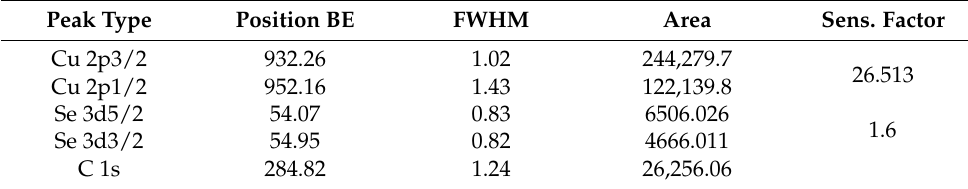
Table 2. Position BE (binding energy), the full width at half-maximum (FWHM) and area of Cu 2p, Se 3d and C 1s.